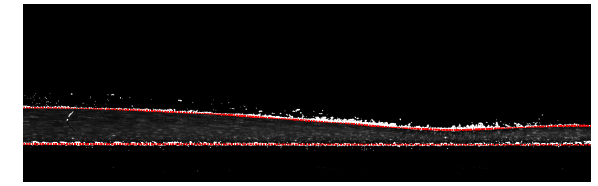
Figure 6. Interface identification example.